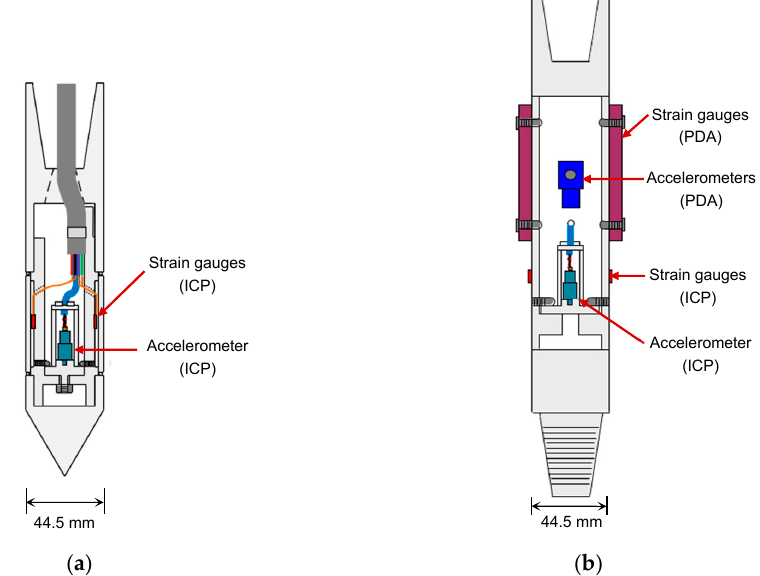
Figure 1. Schematic drawing of the instrumented cone penetrometer (ICP): ( a ) cone tip; ( b ) rod head. PDA—Pile Driving Analyzer.